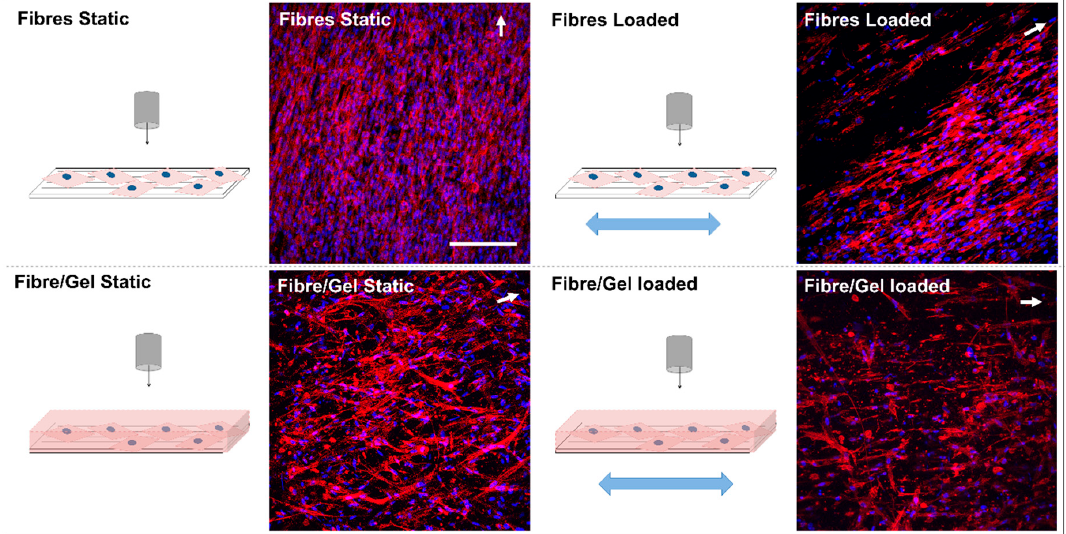
Figure 4. Confocal microscopy (z-stack birds-eye view) demonstrating human mesenchymal stem cell alignment relative to underlying fibre orientation (white arrows) for each group. Cells stained for nuclei (blue) and actin filaments (red). Scale bar = 200 μ m.